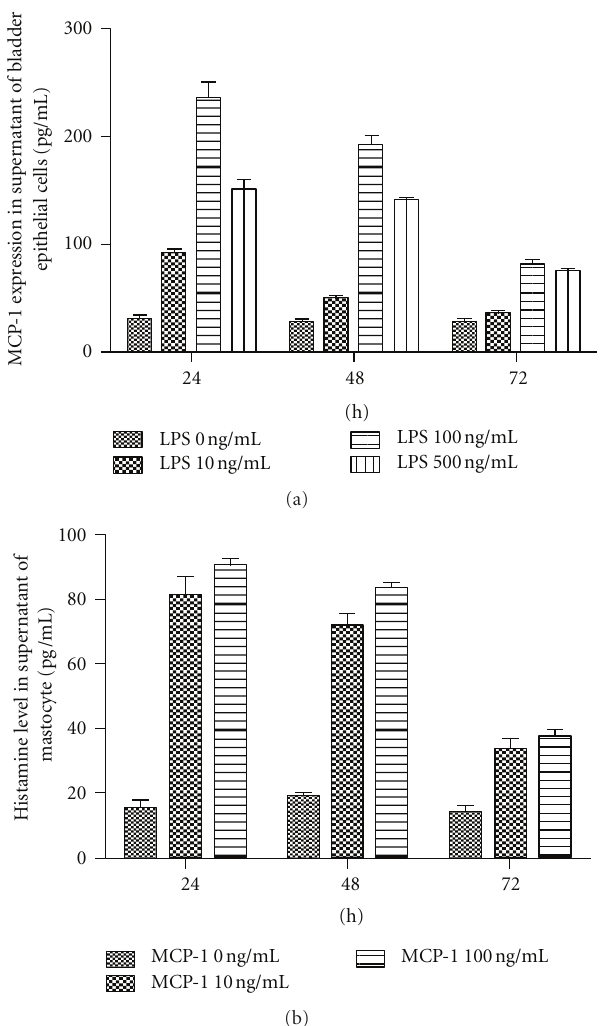
Figure 5: LPS-stimulated MCP-1 release from bladder epithelial cells in a dose- and time-dependent manner (a). MCP-1 induced histamine release from MCs (b). MCP-1 and histamine in the supernatant of bladder epithelial cells and mast cells were detected with ELISA ( n =